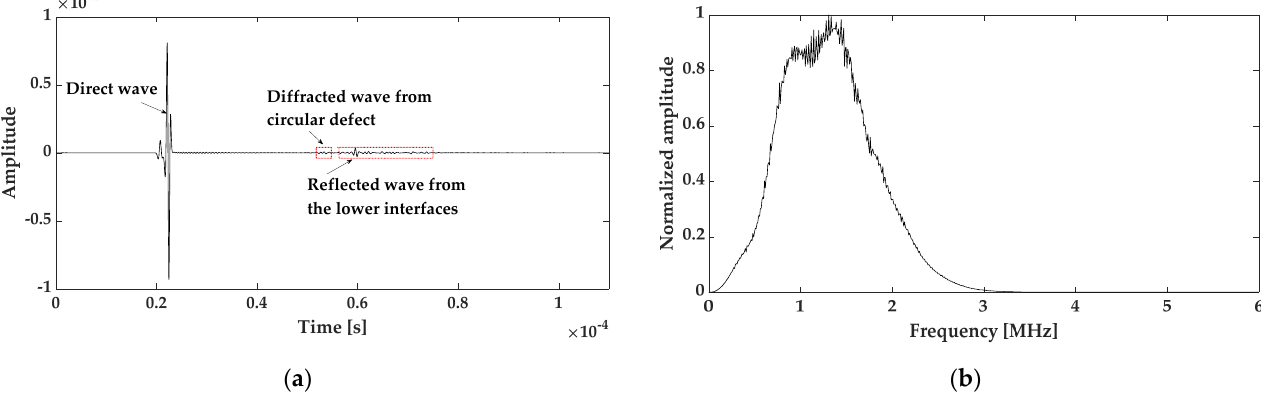
Figure 6. The recorded signal of the 19 th transducer excited with the 1 st transducer. ( a ) The A-scan waveform and ( b ) the corresponding amplitude spectrum.